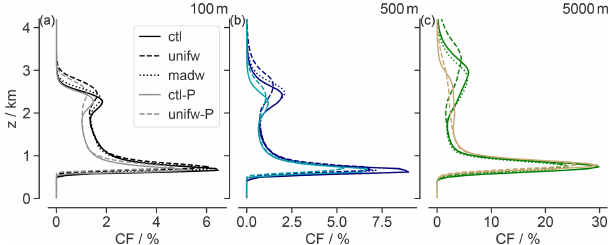
Figure 10. Profiles of second-day domain-averaged cloud fraction at three different horizontal resolutions (a–c) for all